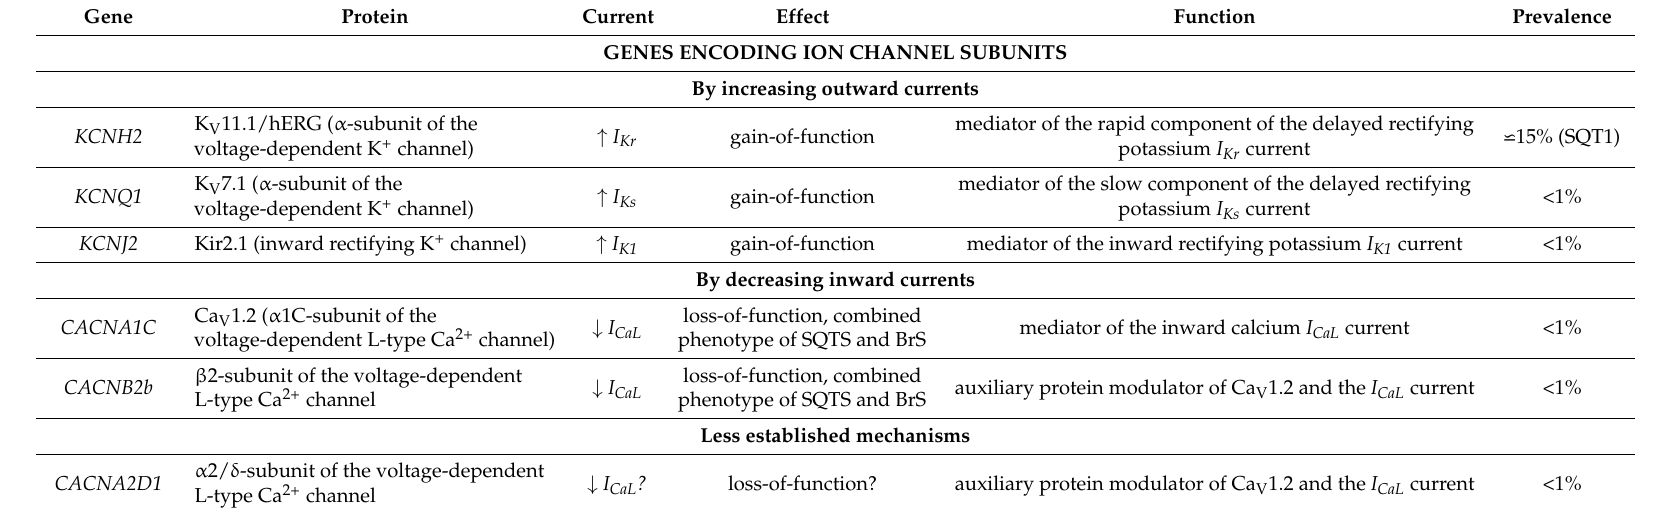
Table 2. Mutations associated with the